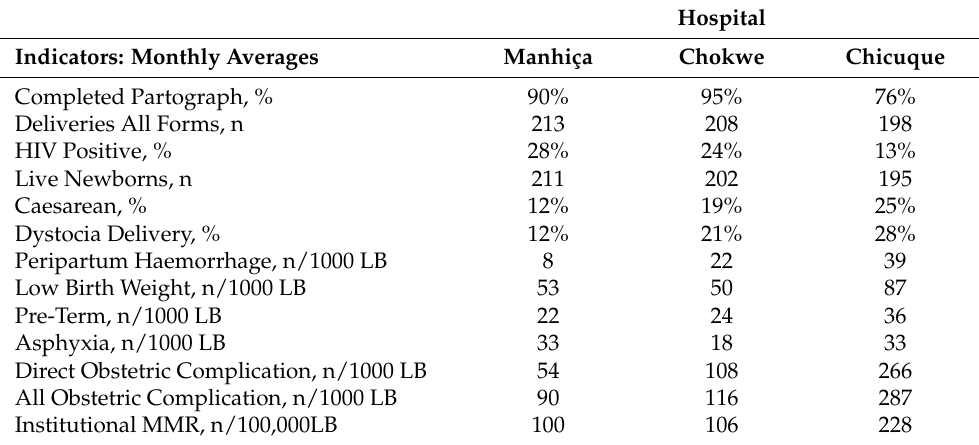
Table 1. Maternity health care indicators (2016–2018), Chicuque , Chokwe , Manhiça hospitals, South- ern